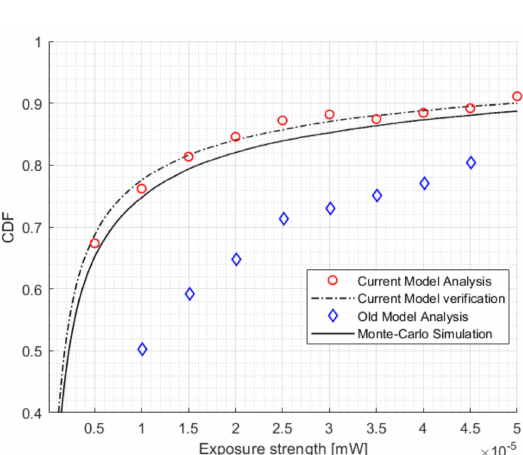
Figure 8. Comparison between the current model developed in this paper, its verification using Monte-Carlo simulations assuming the gain distributions from Section 2.2, and the old model from [25], versus a Monte-Carlo simulation of the exposure using the gain simulated by NYUSIM.